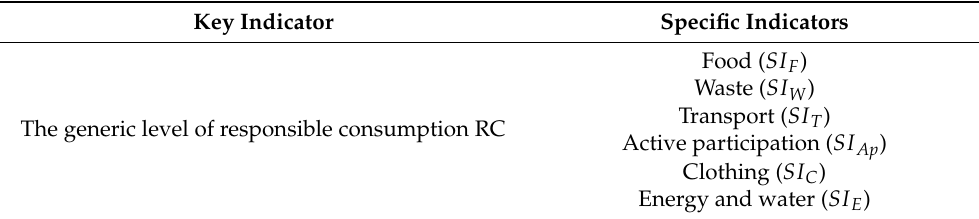
Table 34. Indicators of the level of responsible consumption.